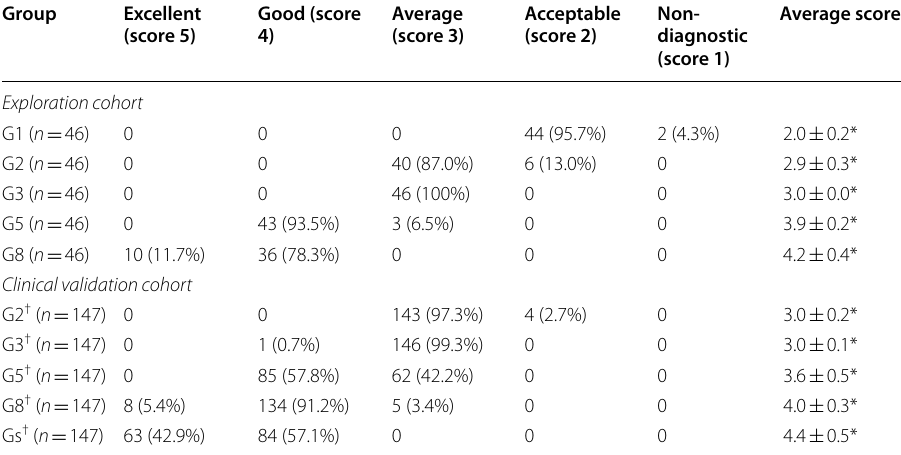
Unless otherwise indicated, data are numbers of patients, and data in parentheses are percentages *Data are mean standard deviation (mean SD) ± ± † Groups from the clinical validation